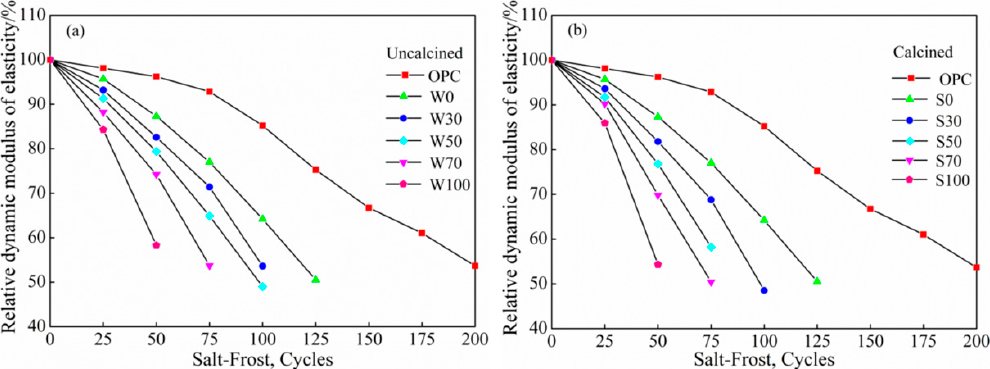
Figure 8. The relationship between the salt-frost and the relative dynamic modulus of elasticity of ( a ) uncalcined and ( b ) calcined.